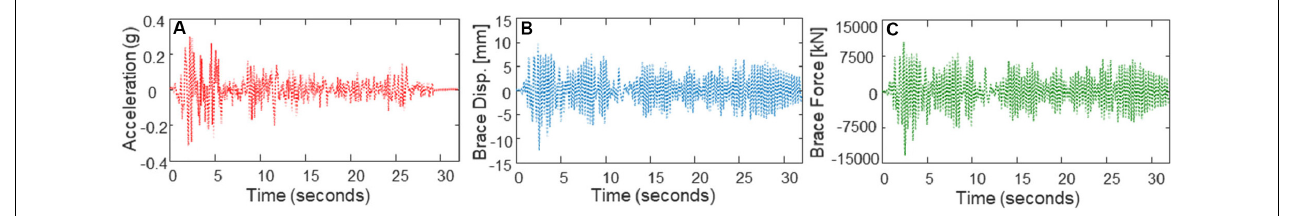
FIGURE 3 | Datasets used for LR model training: (A) El-Centro ground motion acceleration, (B) brace displacement history, and (C) force history, both in local brace coordinates as obtained from the pure analysis.